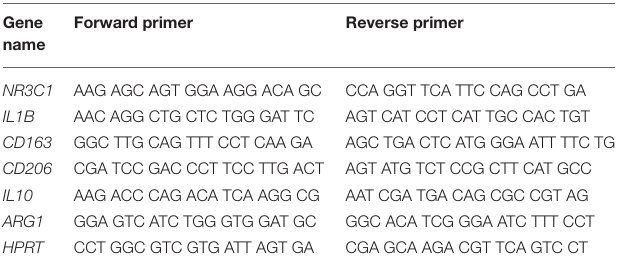
TABLE 2 | Primer sequences used for quantitative RT-PCR analysis.